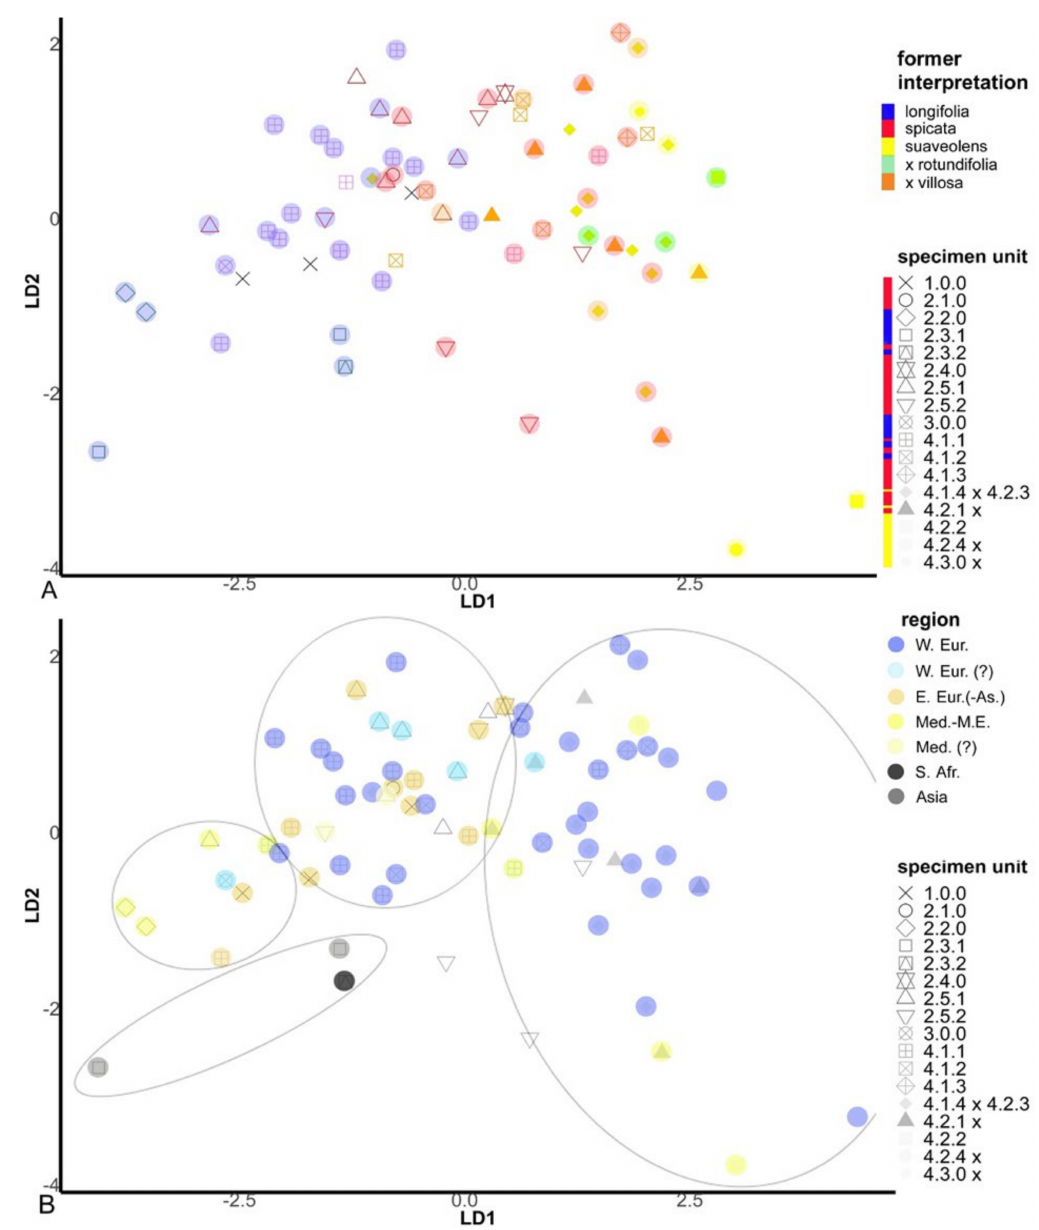
Figure 7. Species perceptions and mint biogeographical origin plotted on discriminant analysis results. Exogene data plotted on existing discriminant analysis. Symbols according to genotypic specimen units. ( A ) Former species interpretation plotted on DA1–2. Colors represent ‘classic’ species (based on plant labels). ( B ) Mint biogeographical regions plotted on DA1–2: (a) Western Europe; (b) Mediterranean area to Middle East, including North Africa; (c) Eastern Europe (to Eurasiatic); (d) Asia; (e) South Africa. Colors represent different regions of origin from the wild gene source. Symbols in grey (no color) are cultivated or introduced taxa without known origin/location. Ellipses are arbitrary as manually